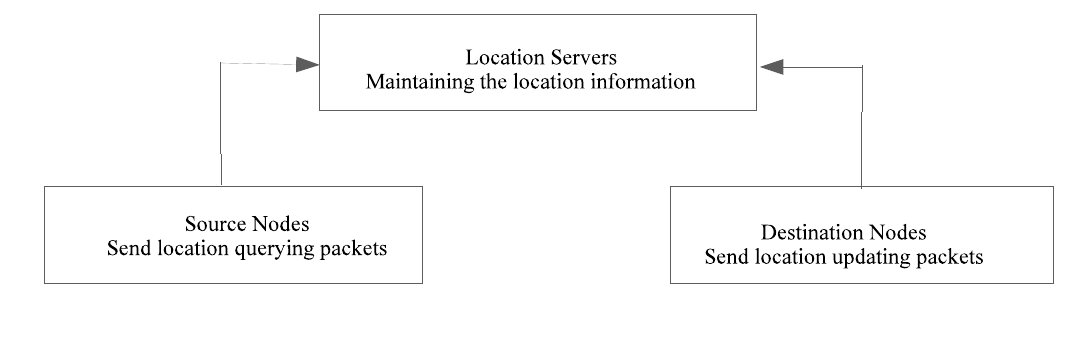
Figure 1. General architecture for a location